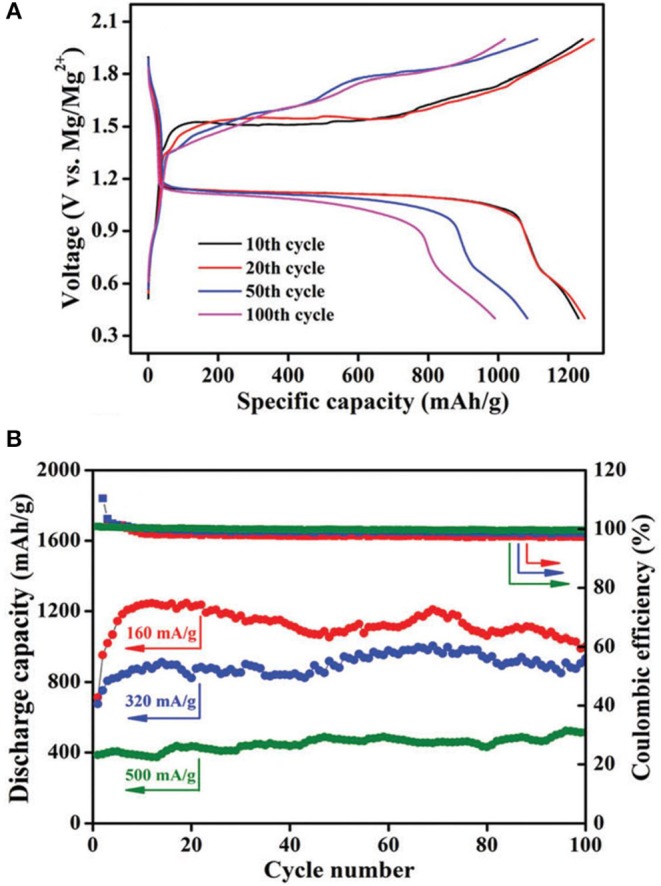
(A) Ggalvanostatic charge–discharge profiles of the Mg-S-CNT cell with the electrolyte [B(HFP)3]-Mg-MgCl2/DME at 0.1 C; (B) Discharge capacities and Coulombic efficiencies at different current rates. Reproduced from reference (Du et al., 2017) with permission from the Royal Society of Chemistry.